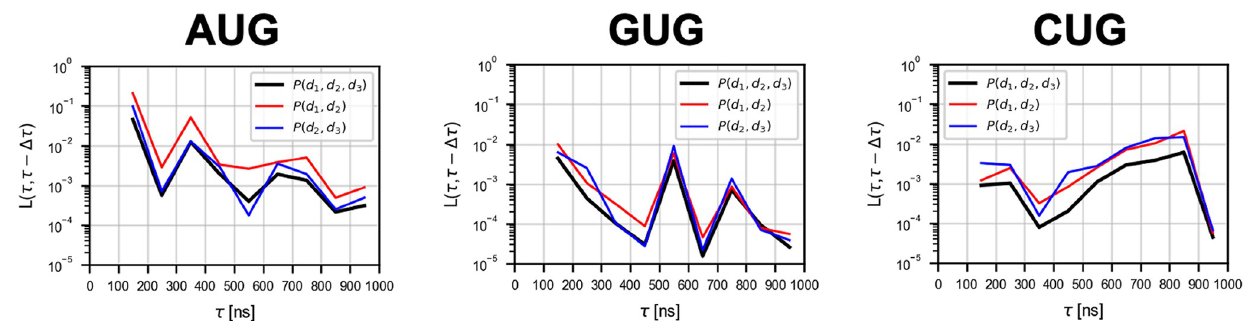
Fig 3. Convergence of free energy profiles with time evolution. The L ( τ , τ − Δ τ ) of P ( d 1 , d 2 , d 3 ), P ( d 1 , d 2 ), and P ( d 2 , d 3 ) are shown (see Eq 5; Δ τ = 100 ns). The data points are plotted between the two consecutive time points ( τ − Δ τ ) and τ .